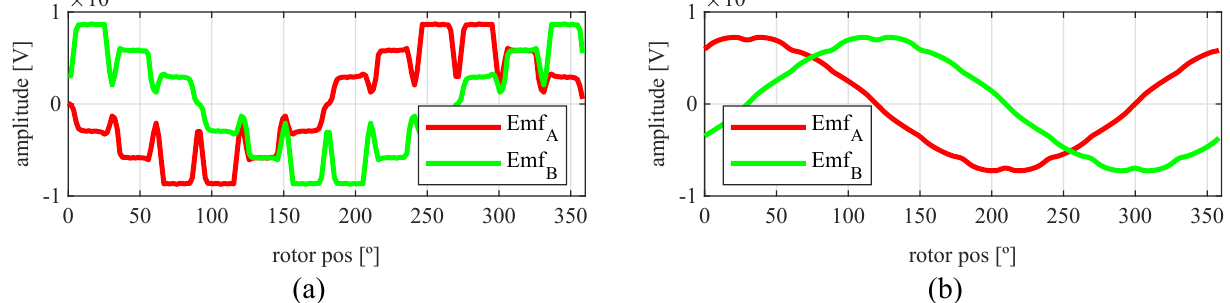
Figure 24. Full pitch twelve-slot resolver EMFs skewed for the least THD ( a ) before skew and ( b ) with skew. With this resolver, the signals could be improved as well. As with the four-slot full pitch resolver, the geometry to obtain the EMFs with the lowest THD with and without skew were different. The obtained signals are compared with the ideal sine and cosine in Figure 25. The angular position obtained with this resolver (Figure 26) was compared with the ideal position. Then, the error shown in Figure 27 was calculated.